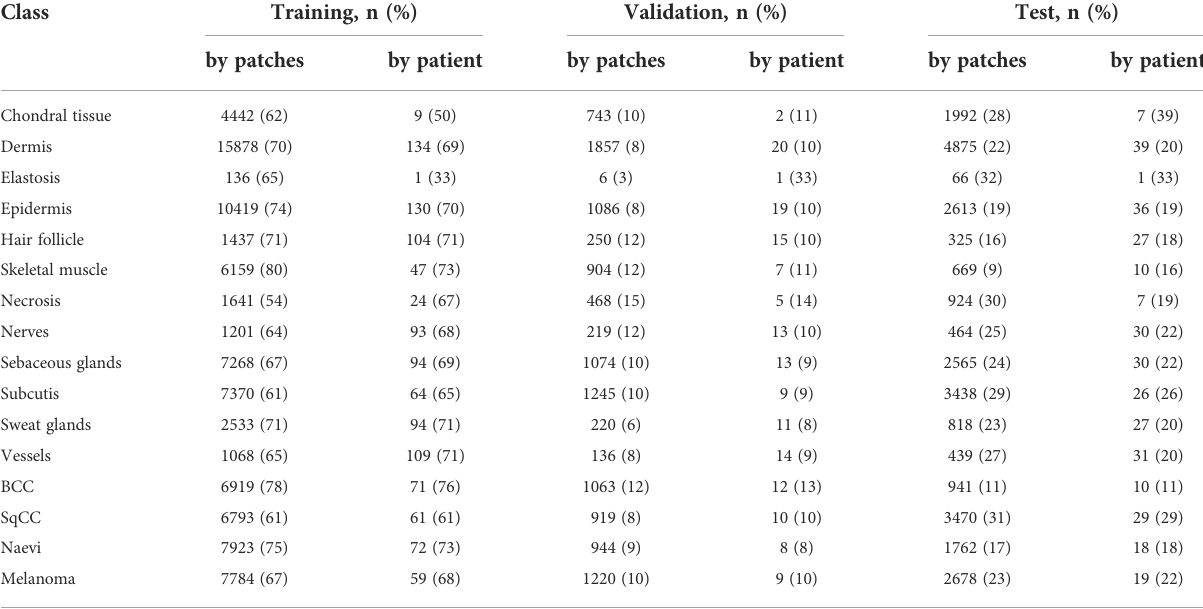
TABLE 1 Number of image patches and patients in the training, validation and test